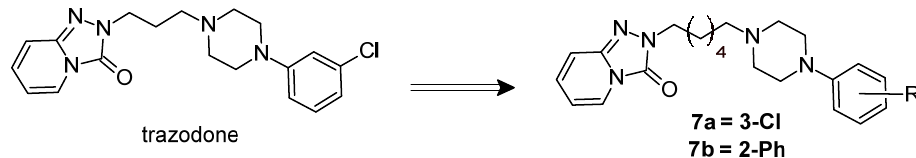
Figure 1. Structures of trazodone and its hexyl derivatives.